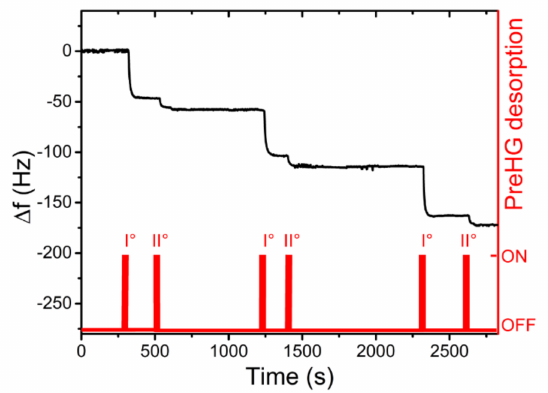
Figure 9. An example of mercury-vapour detection by QCM of three consecutive PreHG expositions and desorptions. The preconcentration (4 min each) happens after each double desorption, whereas the QCM remains in a stable state.